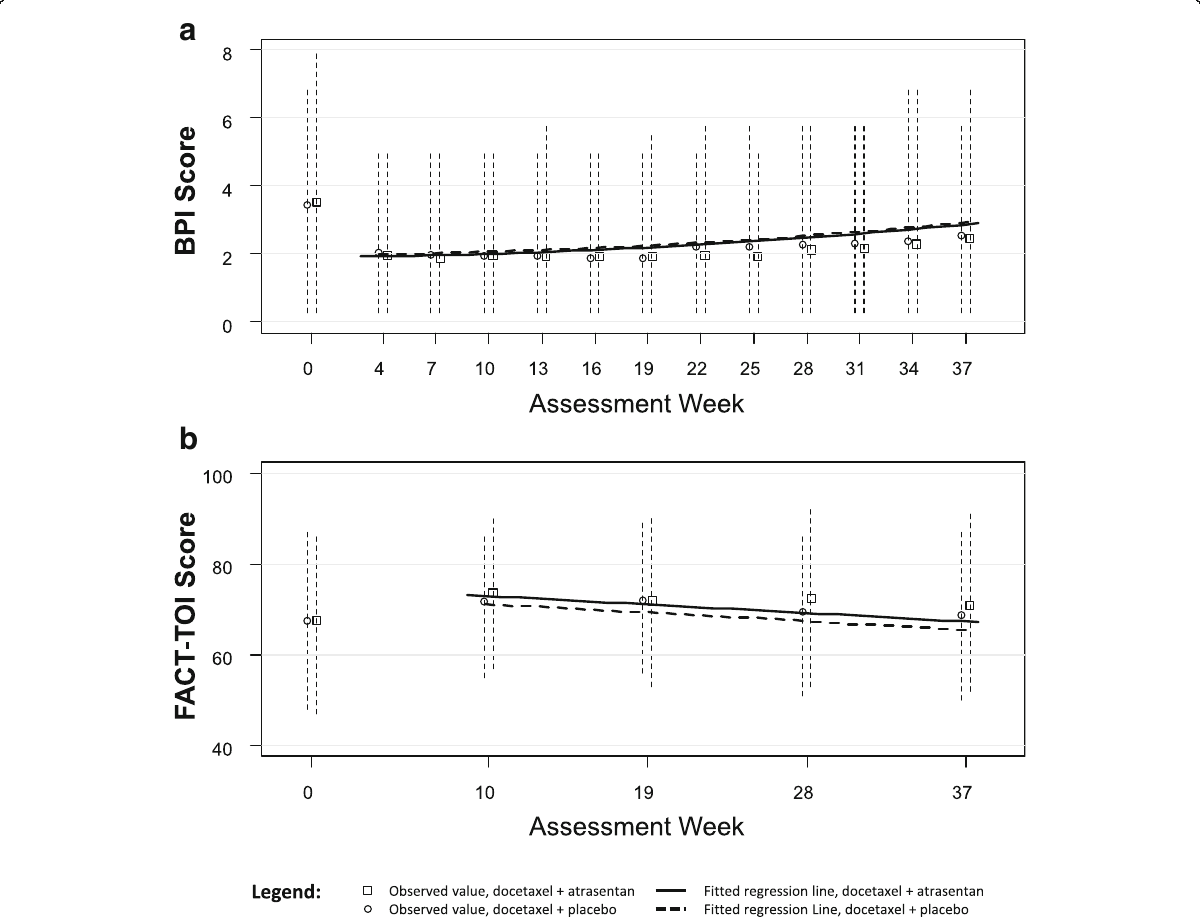
Fig. 4 Mean observed BPI Worst Pain and FACT-P TOI scores over time. The fitted lines from the linear mixed models regressions are also shown. The dashed vertical lines show the spread of the observed data by arm and assessment time using the 75% intraquartile range